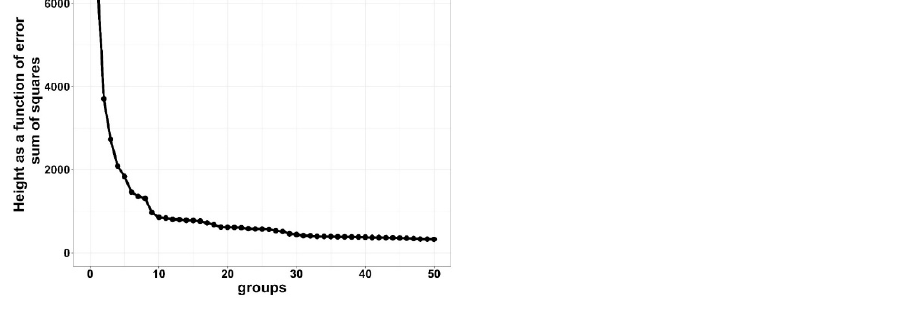
Figure 1. Elbow plot of HIGH ( ≥ 15%) bovine respiratory disease (BRD) morbidity cohorts demon- strating height as a function of error sum of squares for clustering cohorts with bovine respiratory disease from 10 US commercial feedlots. Distance between points is a difference in height of error sum of squares. Greater heights are suggestive of larger differences between groups.